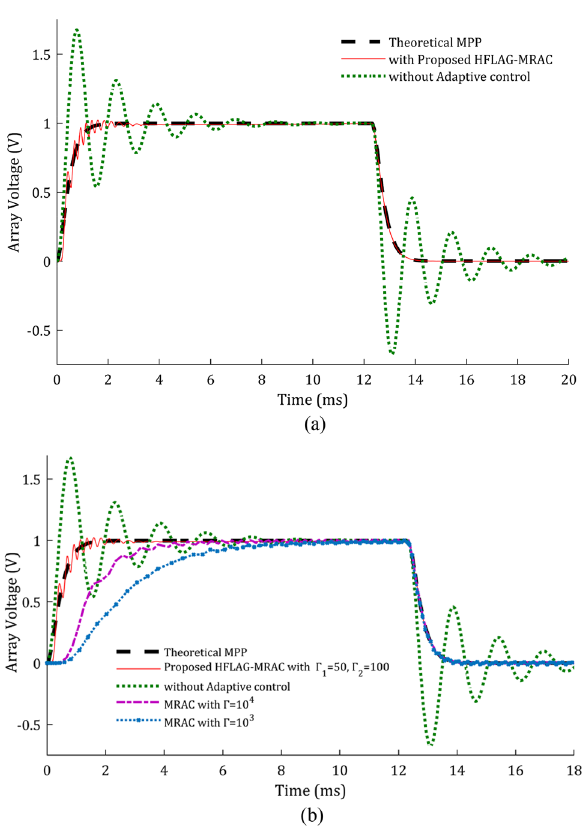
Figure 12. ( a ) Performance of adapted array voltage with the proposed HFLAG-MRAC, theoretical MPP voltage and un-adapted array voltage at early adaptation stage, ( b ) Array voltage performance comparison at early adaptation